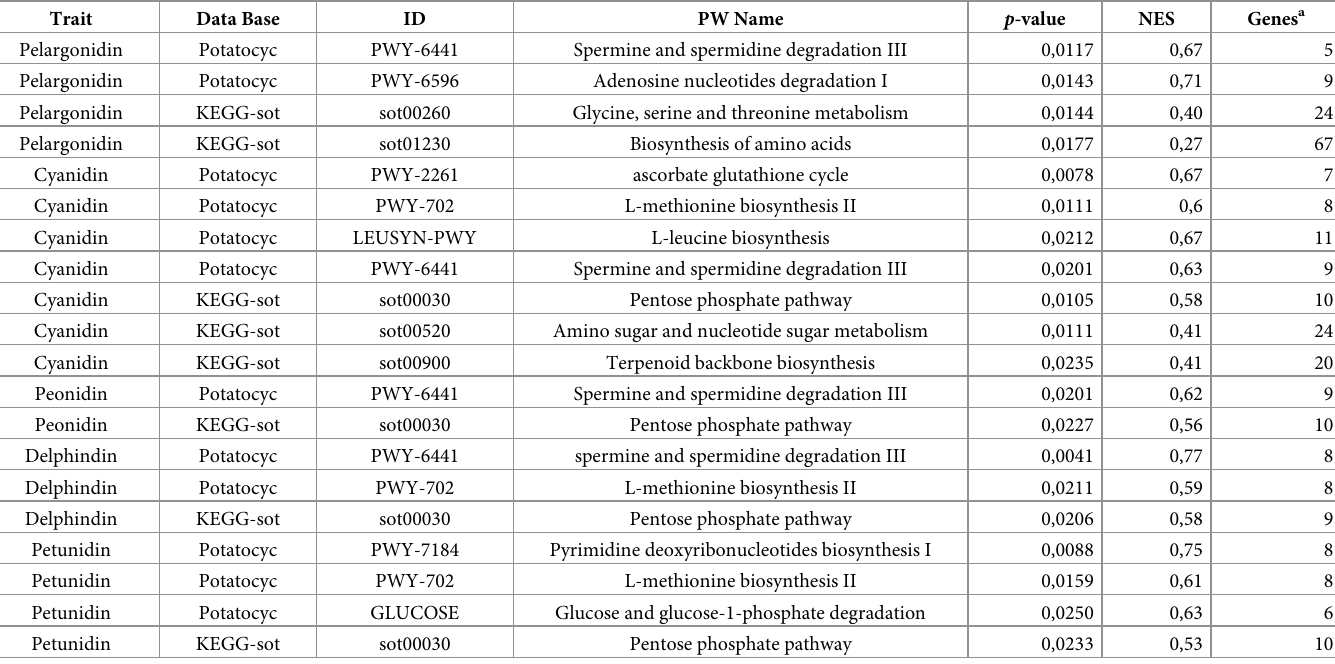
Table 3. Summary of the pathway-based analysis for pathways with p -value < 0.03 to five anthocyanin compounds in Solanum tuberosum group Phureja.